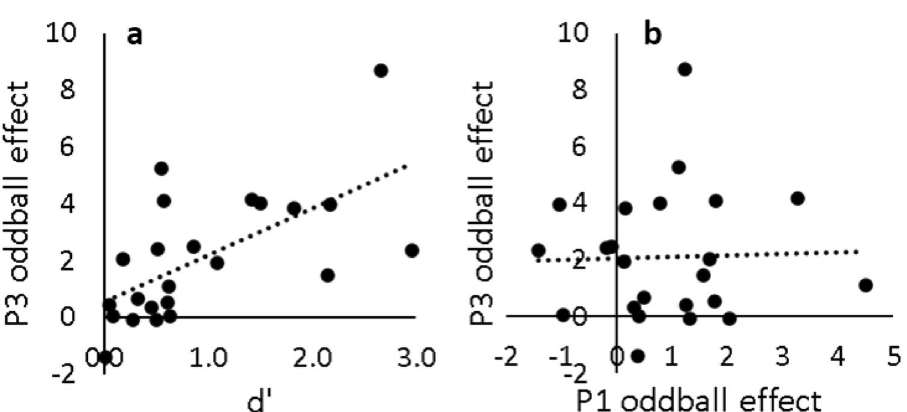
Figure 3. ( a ) Mean counterfeit sensitivity (d ′ ) collapsed across all denominations and counterfeit qualities as a function of the P3 oddball effect (counterfeit—genuine) at Pz. ( b ) P3 (450–600 ms) oddball effect at electrode Pz as a function of P1 (50–100 ms) oddball effect at electrode Oz. Each dot represents data from one